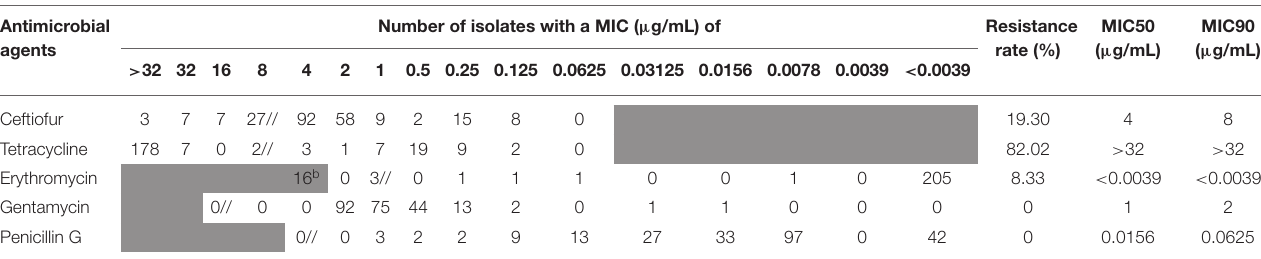
Number of isolates with a MIC ( µ g/mL)